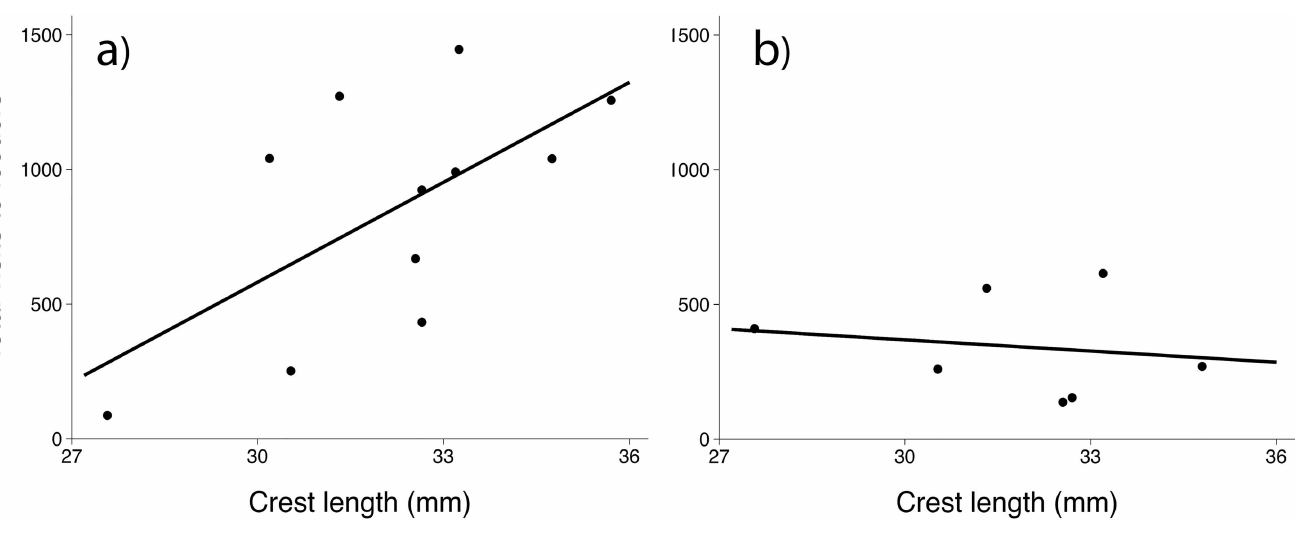
PLOS ONE | https://doi.org/10.1371/journal.pone.0185584 October 3,